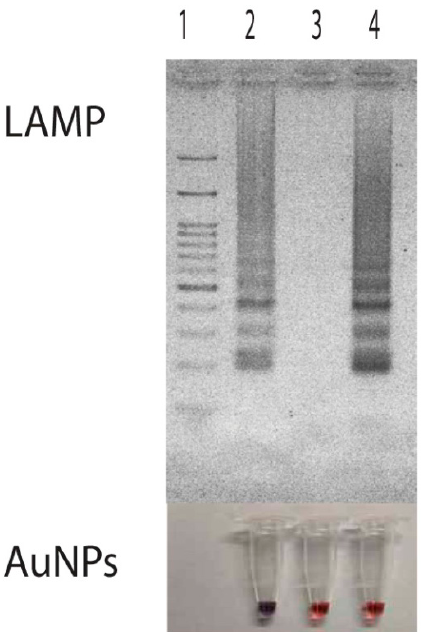
Figure 3. Amplification of p30 gene by LAMP and its signal detection based on gold nanoparticles. Lane 1, 100 bp marker; Lane 2, Ehrlichiacanis DNA; Lane 3, non template control. p30 gene and Lane 4 non target Listeria monocytogenase DNA from LAMP